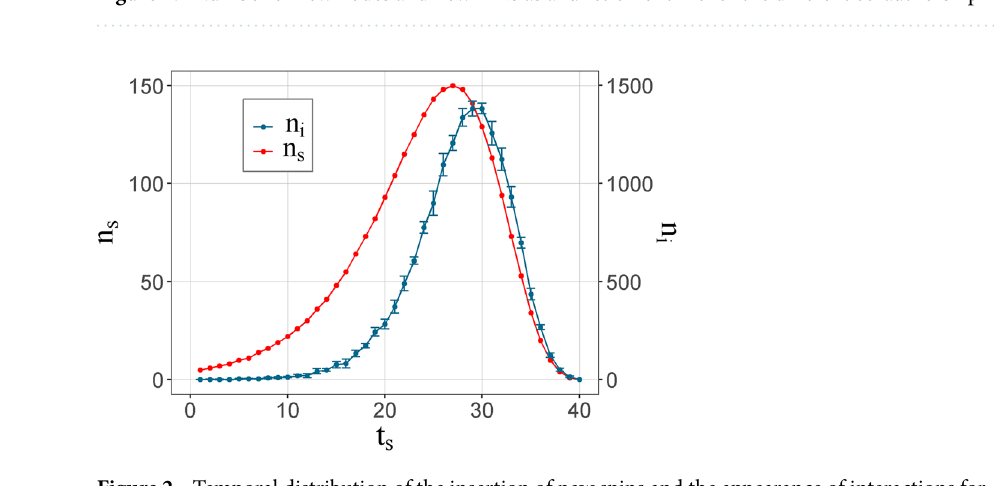
Figure 1. Number of new nodes and new links as a function of time for the different co-authorship networks.